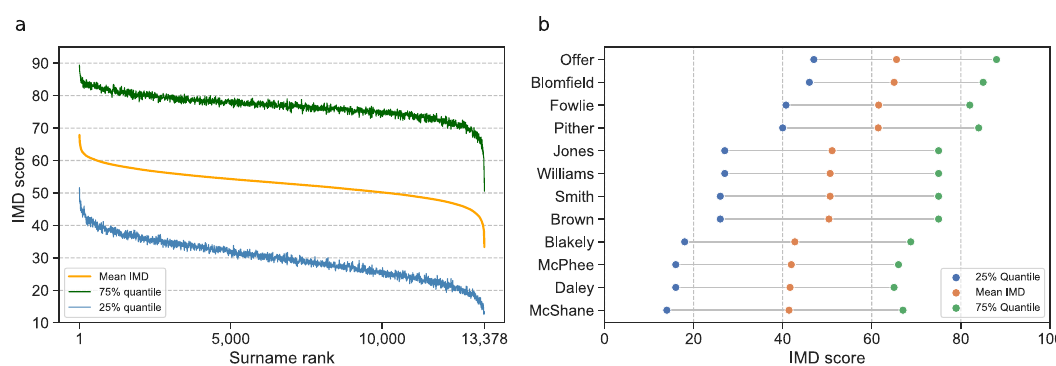
Fig. 2 Mean Index of Multiple Deprivation (IMD) scores distribution of family names. a Mean IMD scores and inter-quartile ranges for the 13,378 long- established family names with 100 or more bearers in 1851 and 200 or more adult bearers in 2016, ranked from least to most deprived; b names extracted from the least deprived, middle and most deprived parts of the distribution. Bars display the interquartile ranges (IQRs) about the mean IMD values. The numbers of adult name bearers (n) in 2016 in ( b ) are 677 (Offer), 513 (Blom fi eld), 524 (Fowlie), 613 (Pither), 424,930 (Jones), 295,271 (Williams), 550,878 (Smith), 260,944 (Brown), 562 (Blakely), 3756 (McPhee), 7096 (Daley), and 3079